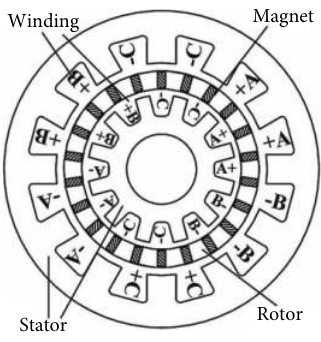
Fig. 17 Topology of DSSA-VPMM (reprinted with permission from Ref. [59], © 2014 IEEE).